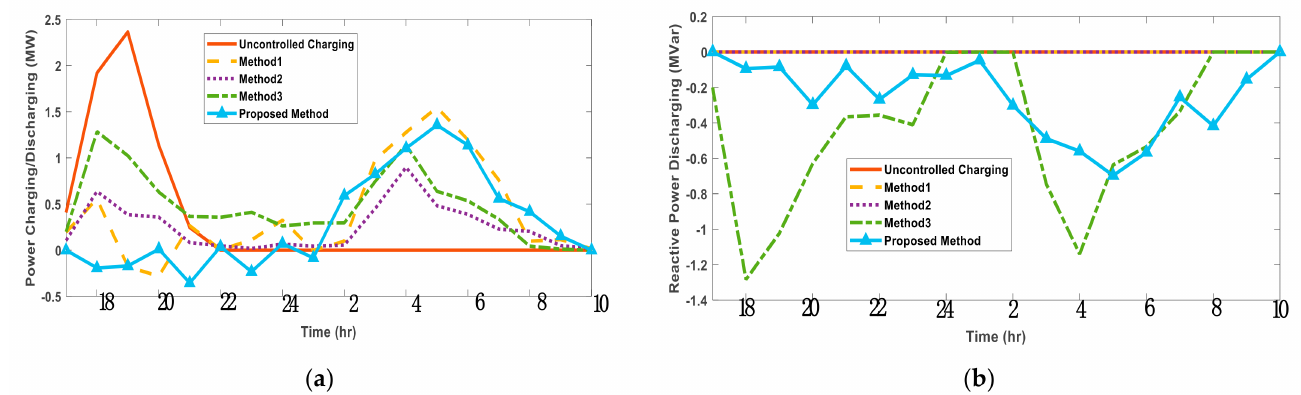
Figure 14. Schedule of ( a ) active power for EVs under different methods and ( b ) reactive power for EVs under different methods for price signals in the spring season.